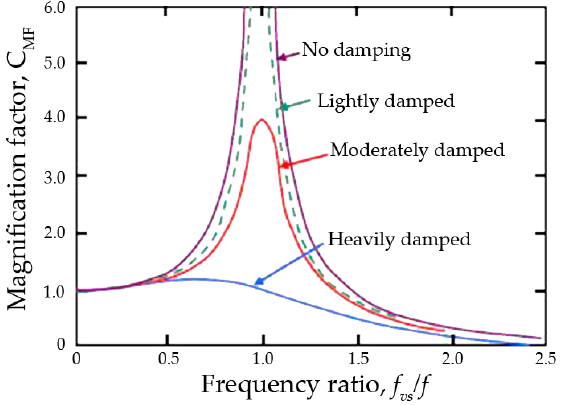
Figure 5. Magnification factor, C MF .